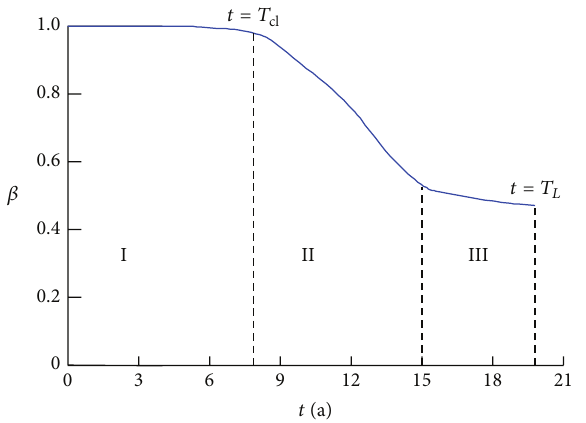
Figure 10: Effect of corrosion on reduction in pile foundation strength.